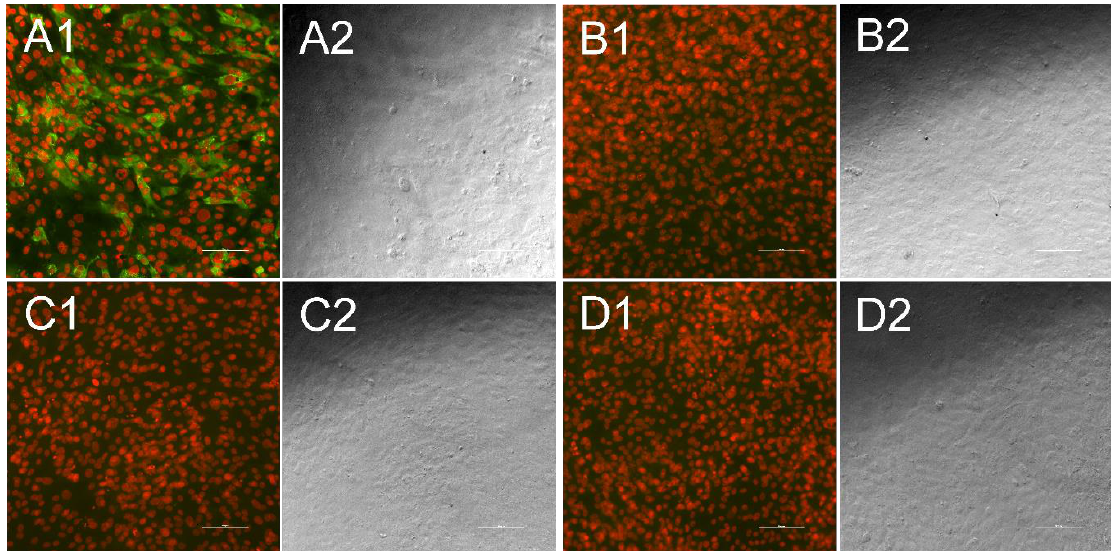
Figure 3. Indirect immunofluorescence test for atypical porcine pestivirus (APPV)-specific antibodies. Each fluorescence picture (1) is presented alongside a bright field picture, that was taken at the same position (2). Cell nuclei appear in red, while antibodies against APPV are stained in green. When antibodies were present in the sample they bound to KOP-R cells transfected with the chimeric cDNA clone pA/CP7_E1E2-APPV ( A ), while no green fluorescence could be seen when antibody-positive samples were tested against untransfected cells ( B ). Antibody-negative serum samples neither showed significant interaction with transfected cells ( C ) nor with untransfected cells ( D ). Bar is 100 µm.